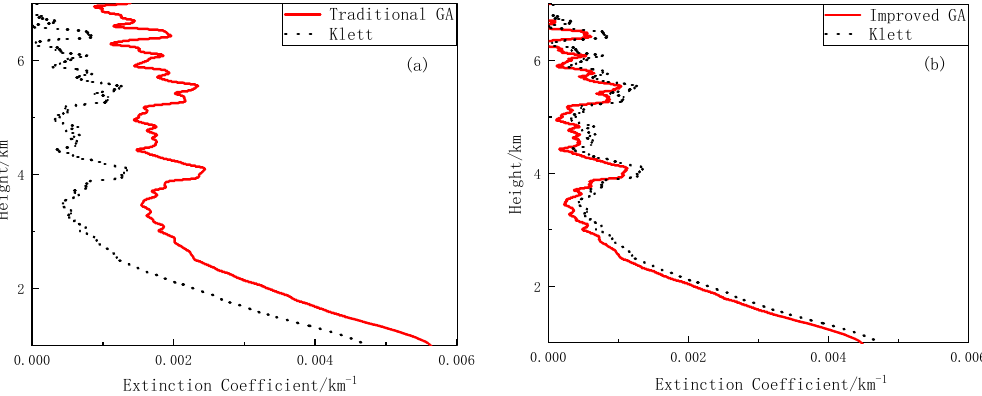
Figure 7. Inversion results obtained with more obvious cloud features: ( a ) using the simple genetic algorithm and the Klett method, and ( b ) using the improved genetic algorithm and the Klett method.